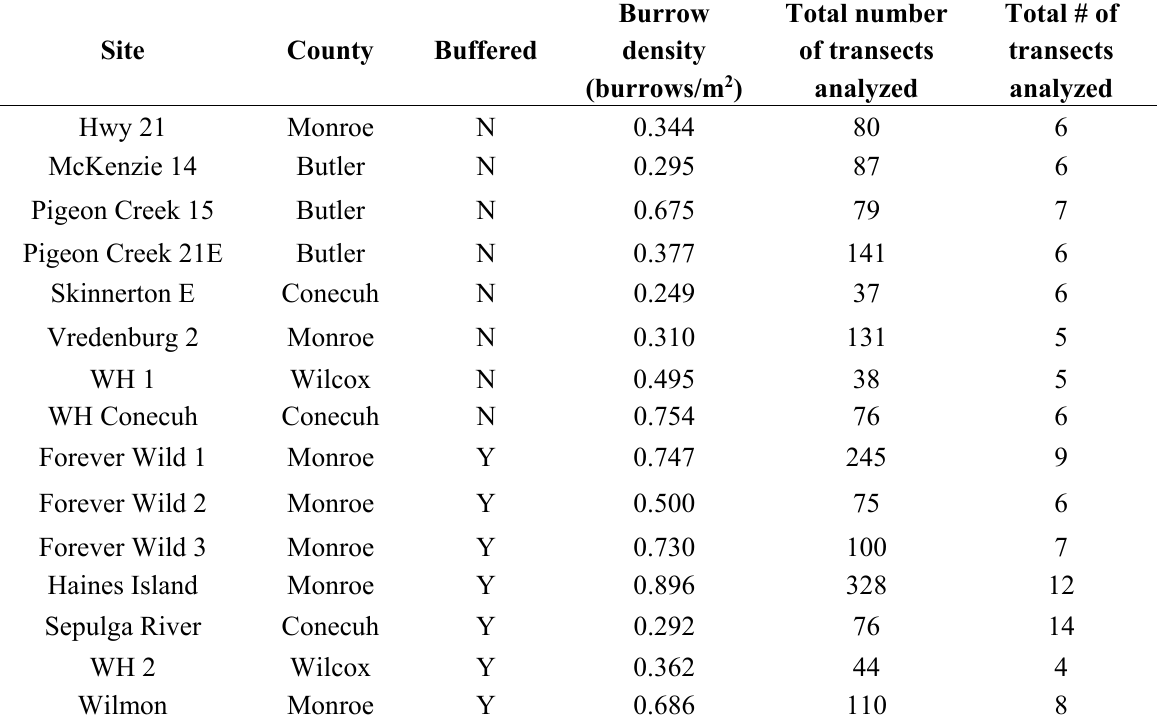
Table 1. Red Hills salamander ( Phaeognathus hubrichti) sites used in this study, in Alabama, USA. Buffered sites are those with buffers of at least 10 m of land above and below the sloped site that are protected from forestry